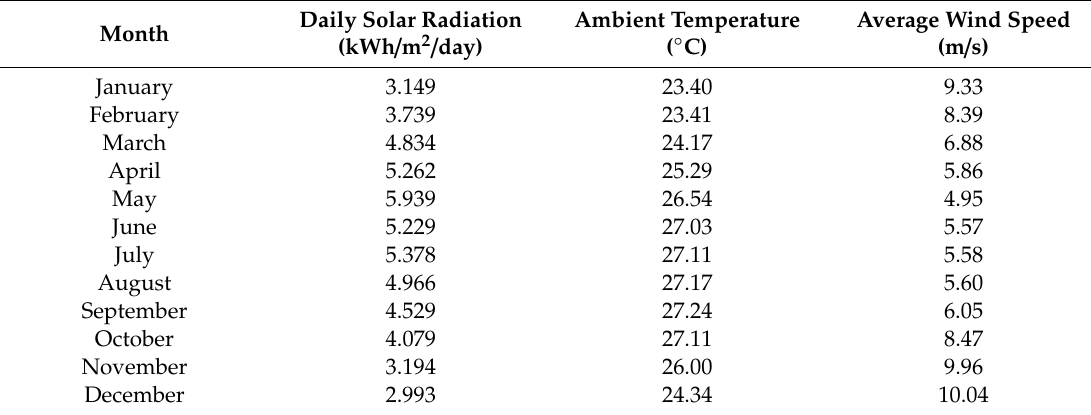
Table 2. Weather data in Basco